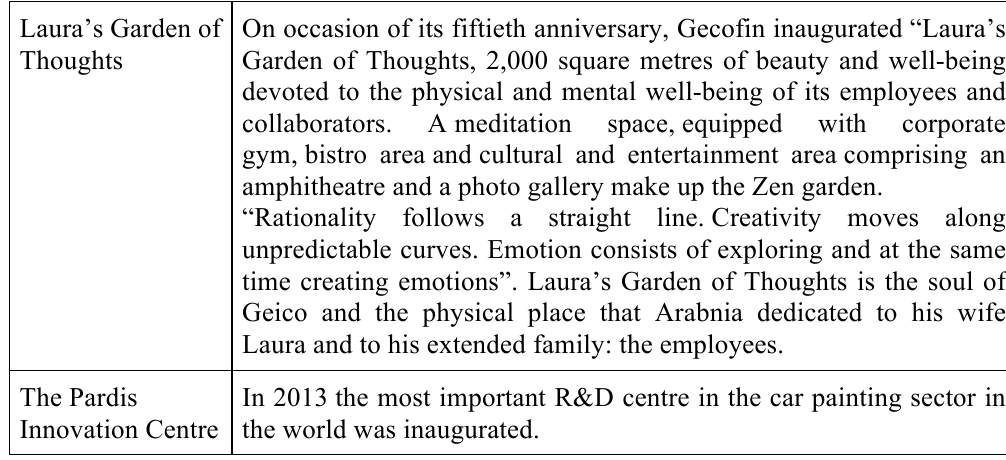
Table 3: Arabnia’s Principles and Geico’s